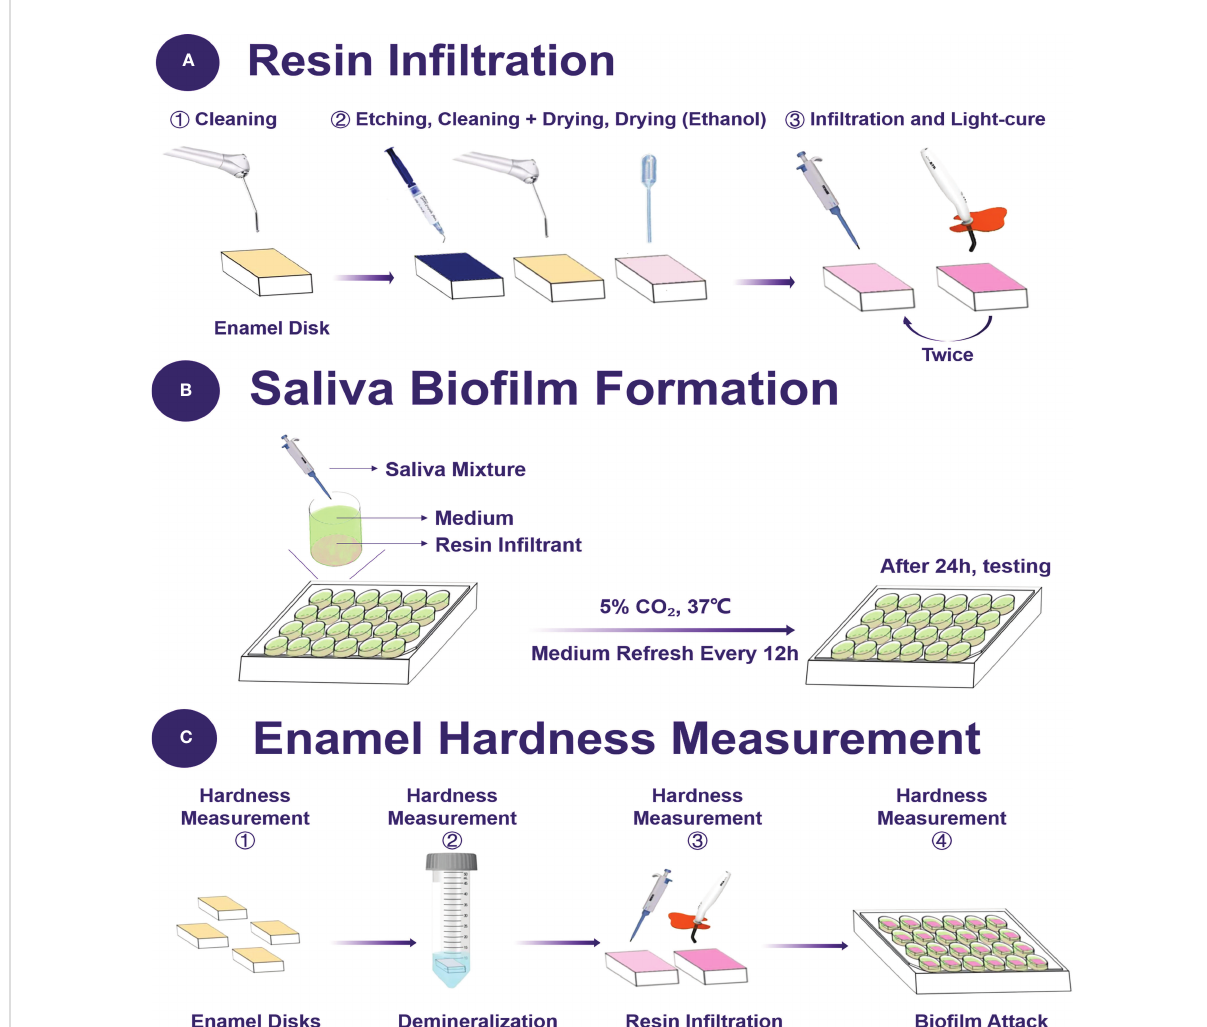
FIGURE 1 Schematic of the experimental design. (A) The protocol of resin in fi ltration, (B) the saliva bio fi lm formation on the resin disks, (C) the time point of enamel hardness